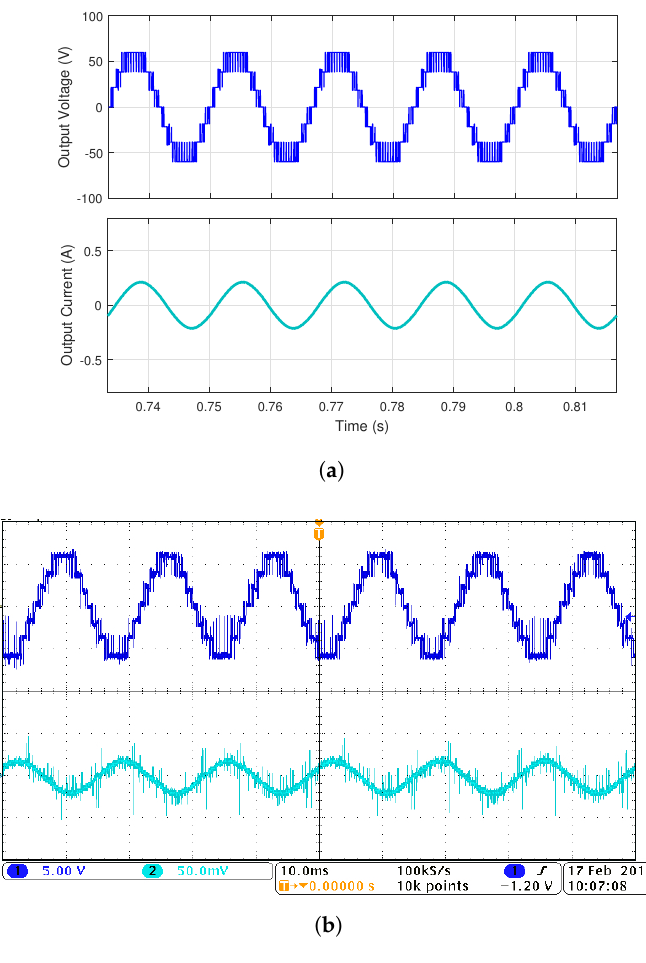
Figure 12. Results of seven-level SS MLI: ( a ) simulated output voltage (top) and load current; ( b ) experimental output voltage (top, 25 V/div) and load current (bottom, 0.25 A/div).